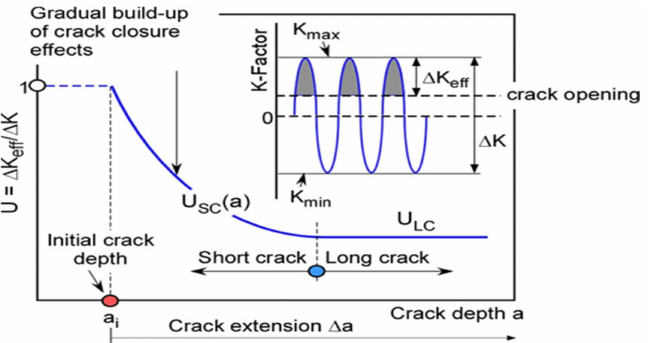
Figure 7. Development of the crack closure phenomenon at the physically short crack propagation stage; schematic